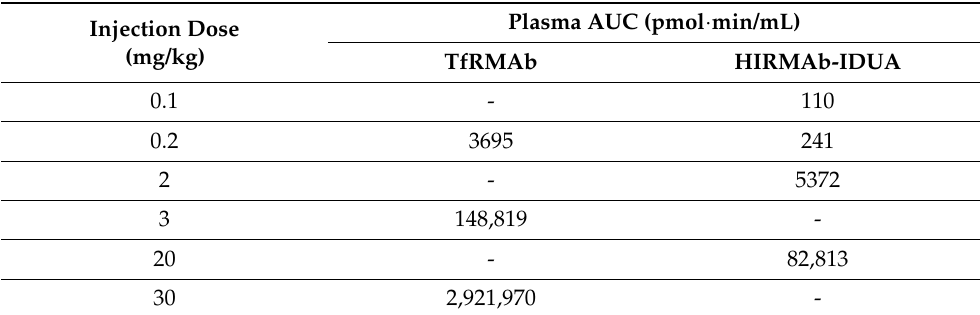
Table 5. Plasma area under the concentration curve (AUC) for TfRMAb and HIRMAb-IDUA fusion protein in Rhesus